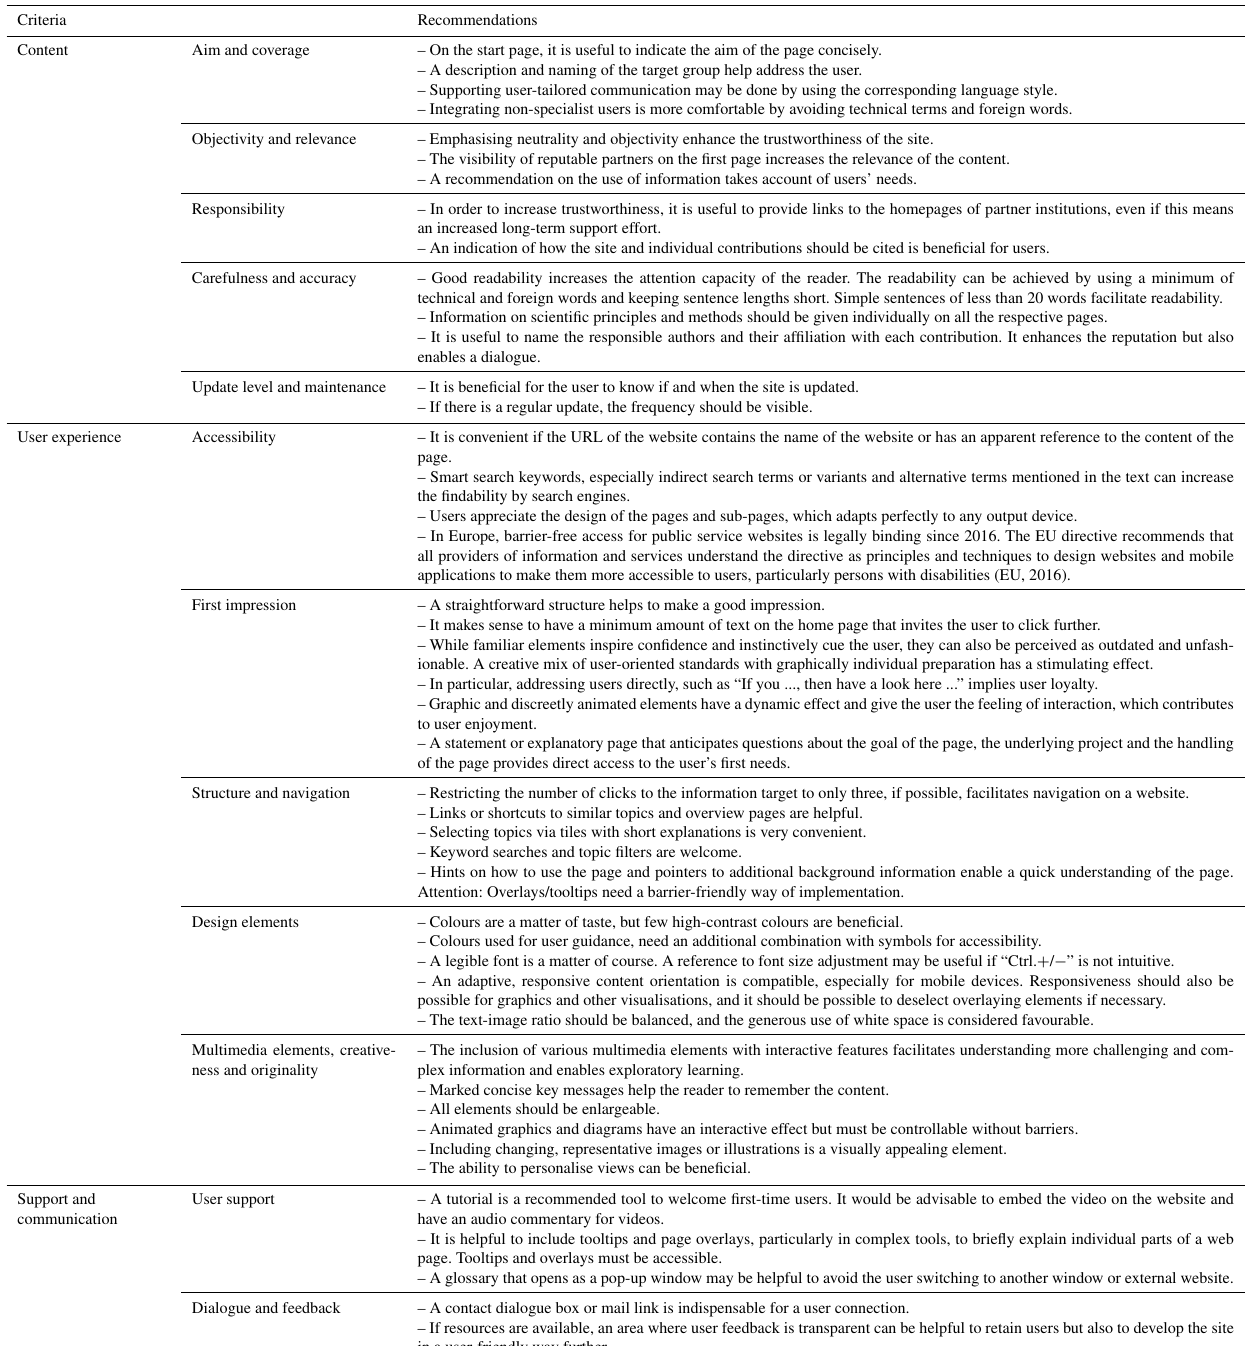
Table A1. Catalogue of Requirements: Specific success criteria and the resulting recommendations from the evaluation Matrix developed for the Net-Zero-2050 Web-Atlas for product comparison of DKTP-Platforms, source: Net-Zero-2050 internal report.